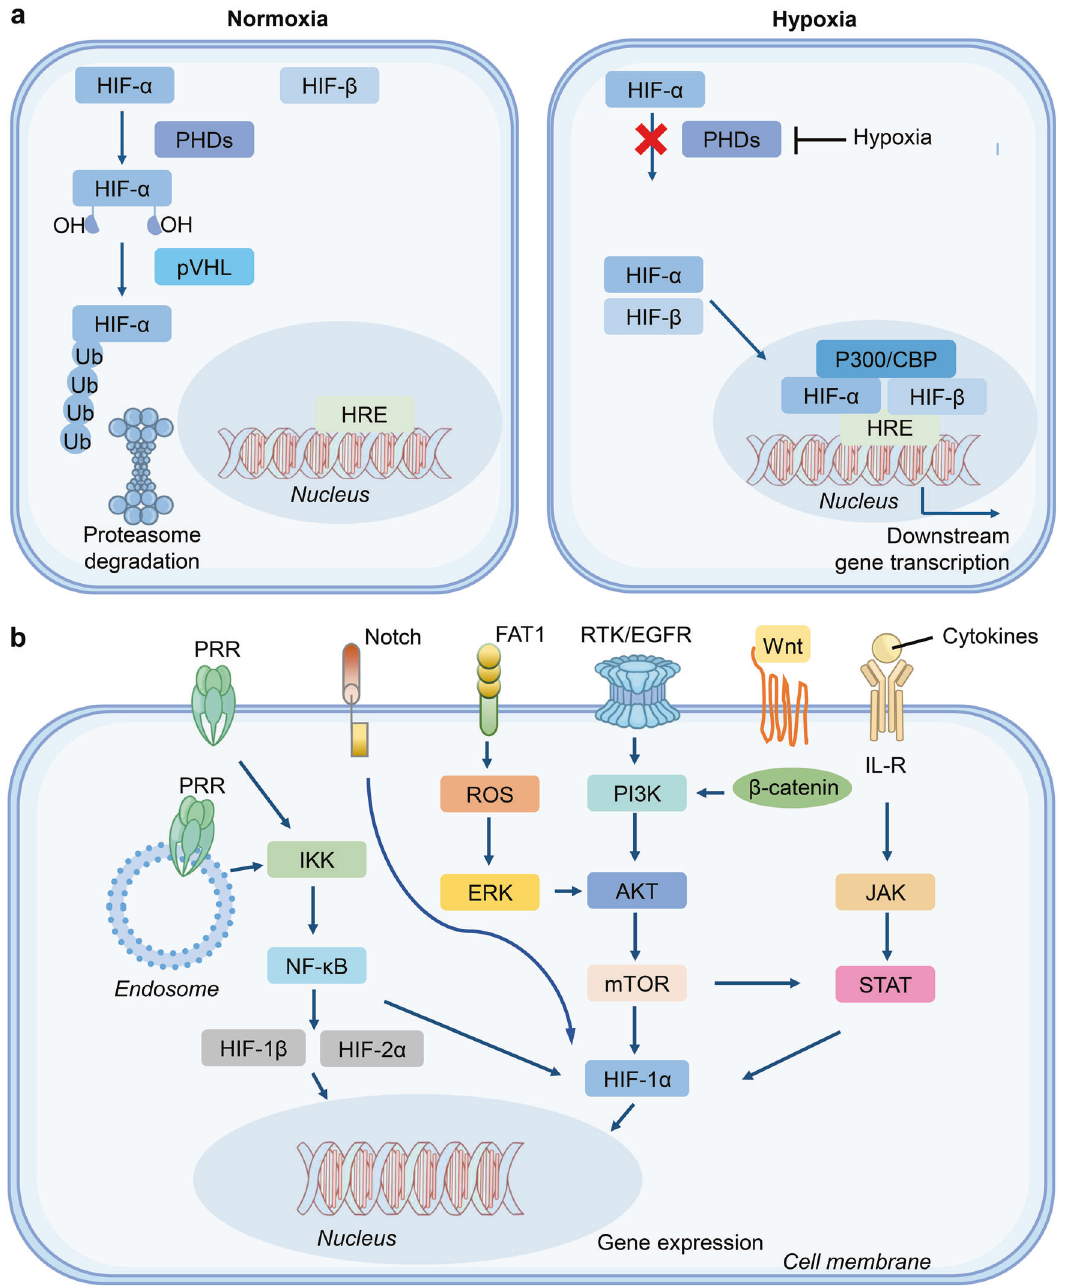
Fig. 2 The underlying principles of hypoxia and cross-talk of HIF signal with multiple pathways. a Under normoxia, HIFs ( α and β subunits) undergo ubiquitination mediated by PHDs (oxygen-dependent proline hydroxylase family) and pVHL (von Hippel – Lindau tumor suppressor protein). The enzymatic activity PHD is prohibited under hypoxia. HIFs are stabilized to promote downstream genes transcription. b The interaction among HIF signal with multiple signaling